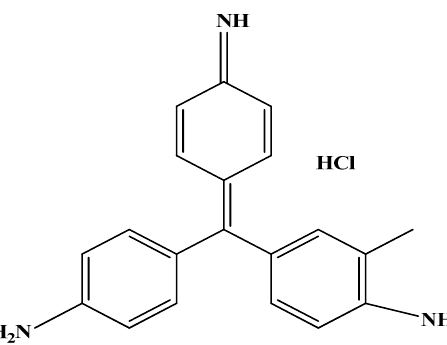
Figure 1. Chemical structure of basic violet 14 dye.